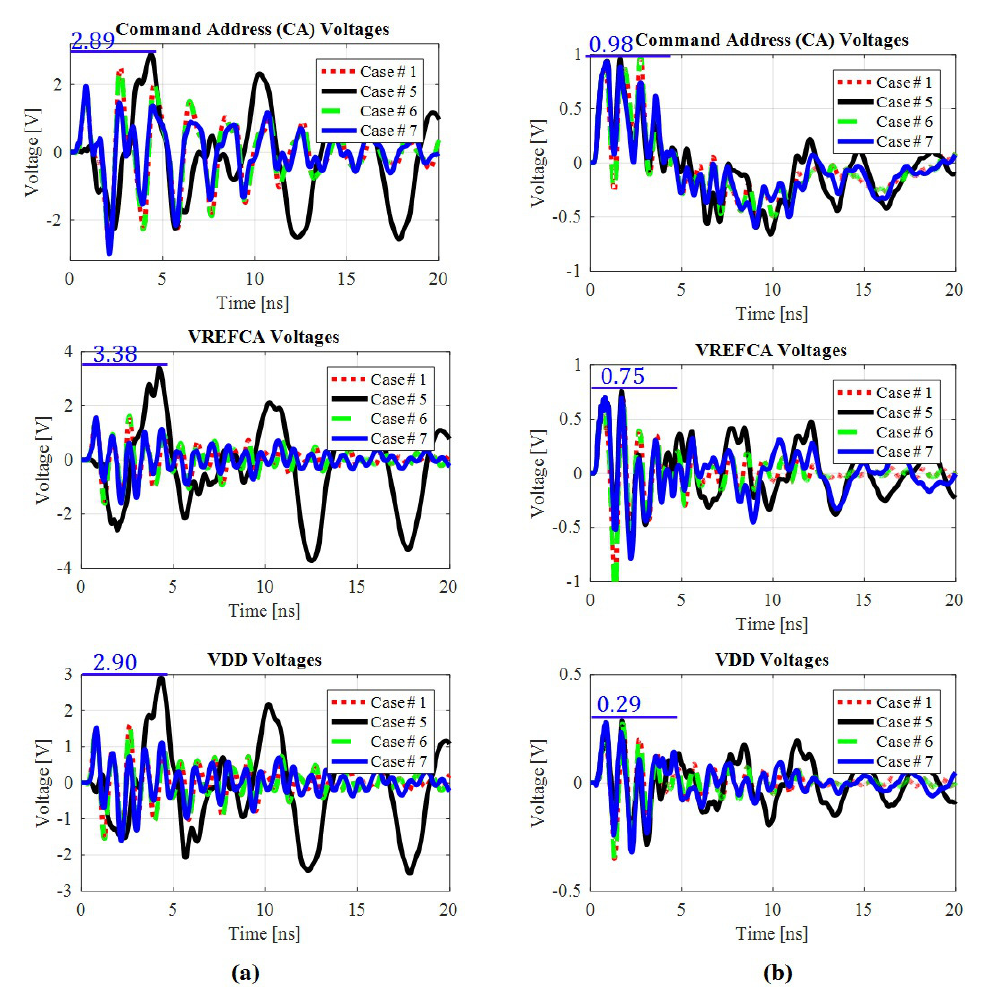
Figure 19. Comparison of DOE cases results to analyze the effect of change in decaps values on induced ESD noises: ( a ) DDR3 module cases; and ( b ) DDR4 module